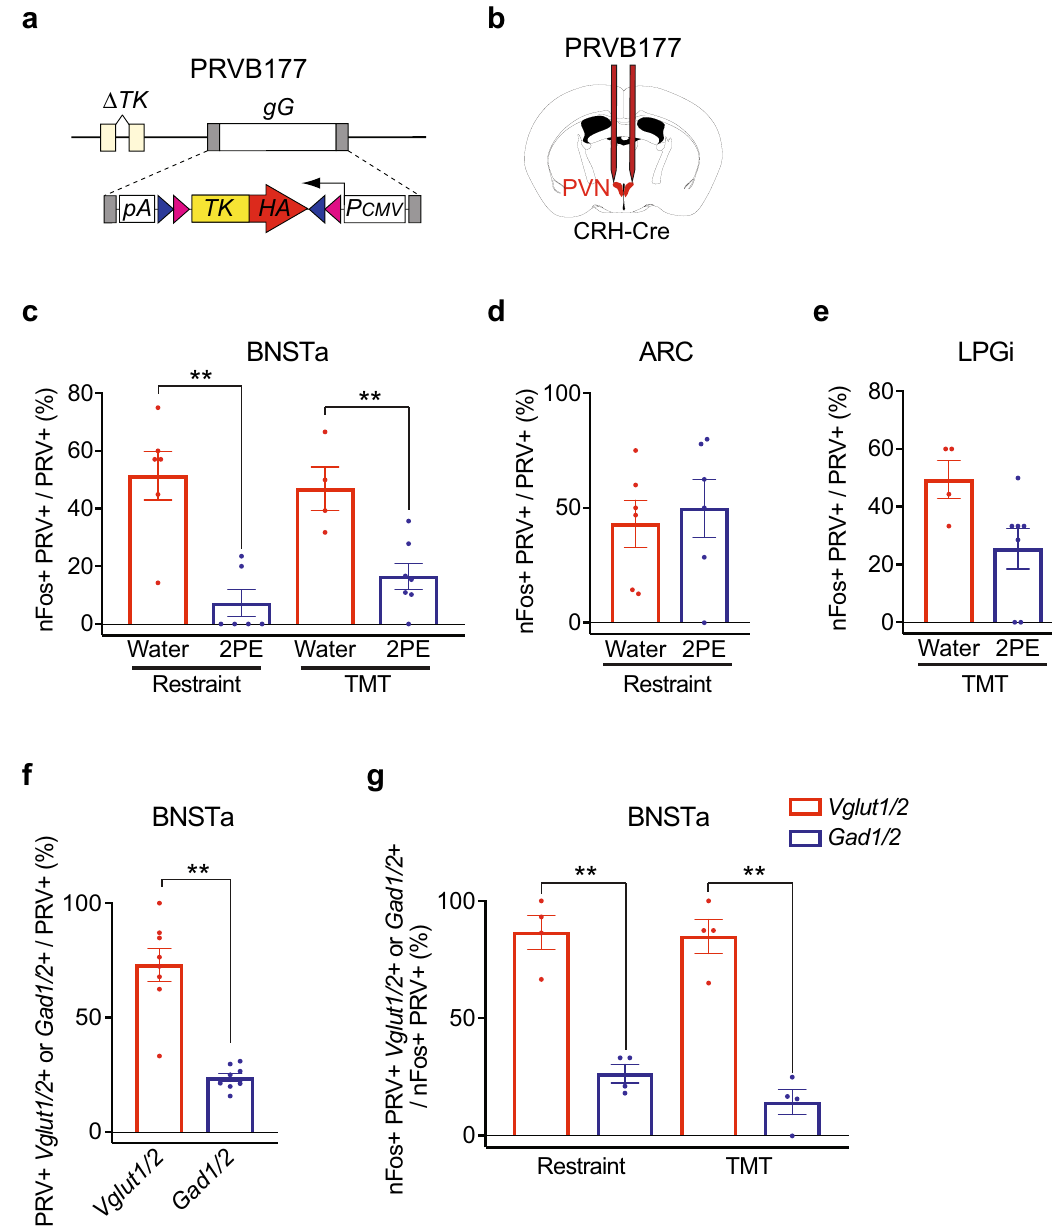
Figure 2. A blocking odorant inhibits stressor activation of BNSTa excitatory neurons upstream of CRHNs. ( a,b ) PRVB177, which has Cre-dependent expression of HA-TK ( a ), was used to infect Cre-expressing CRHNs in CRH-ires-Cre mice ( b ). ( c–e ) On d3pi of CRHNs with PRVB177, animals were exposed to restraint or TMT in the presence of 2PE or water. Brain sections were next costained for HA (PRV) and nFos mRNA. The percentage of PRV+ neurons in a given area that were nFos+ was then determined (nFos+ &PRV+/PRV+ (%)). 2PE significantly decreased the percentage of nFos labeled PRV+ neurons in BNSTa in response to restraint and TMT ( c ). However, 2PE did not significantly affect the percentage of nFos labeled PRV+ neurons in ARC with restraint ( d ) or those in LPGi with TMT ( e ). Column heights indicate means, error bars indicate S.E.M., and dots in the same column indicate different animals. n = 4–7 per condition. Unpaired t test, **P < 0.01. ( f,g ) A higher percentage of BNSTa PRV+ neurons were colabeled for Vglut1/2 than Gad1/2 ( f ). A large majority of BNSTa PRV+ neurons activated by restraint or TMT were colabeled for Vglut1/2 but not Gad1/2 ( g ). Column heights indicate means, error bars indicate S.E.M., and dots in the same column indicate different animals. n = 4 per condition. Unpaired t test, **P <